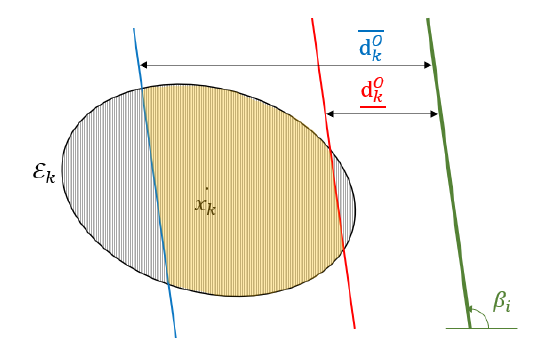
Figure 5. Identification of lower-d O and upper-d O offsets, defining the parallel cuts (red and blue k k lines) with respect to the approximating plane (green line) with orientation β i , thus identifying the section of the uncertain ellipsoid (yellow area) whose distance complies with the measured one.